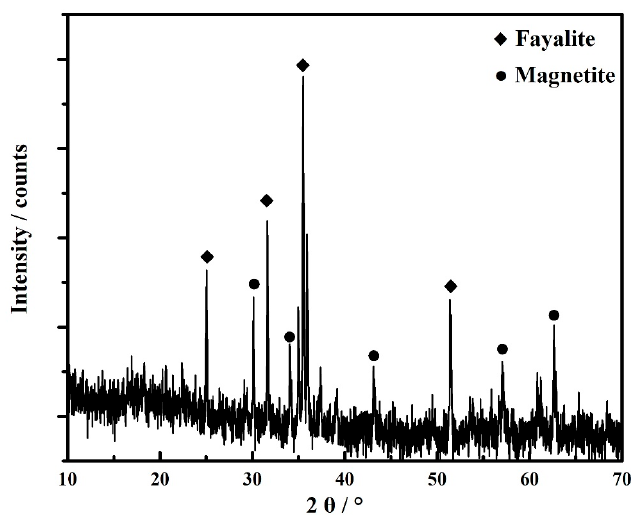
Figure 1. The XRD pattern of copper slag.